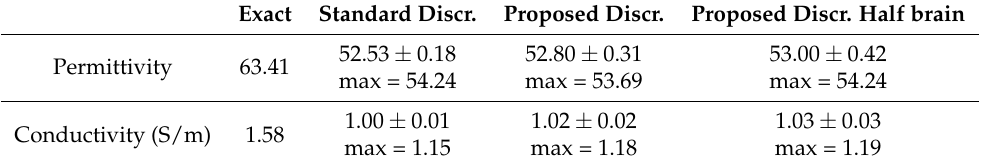
Table 4. Stroke Dielectric Properties.